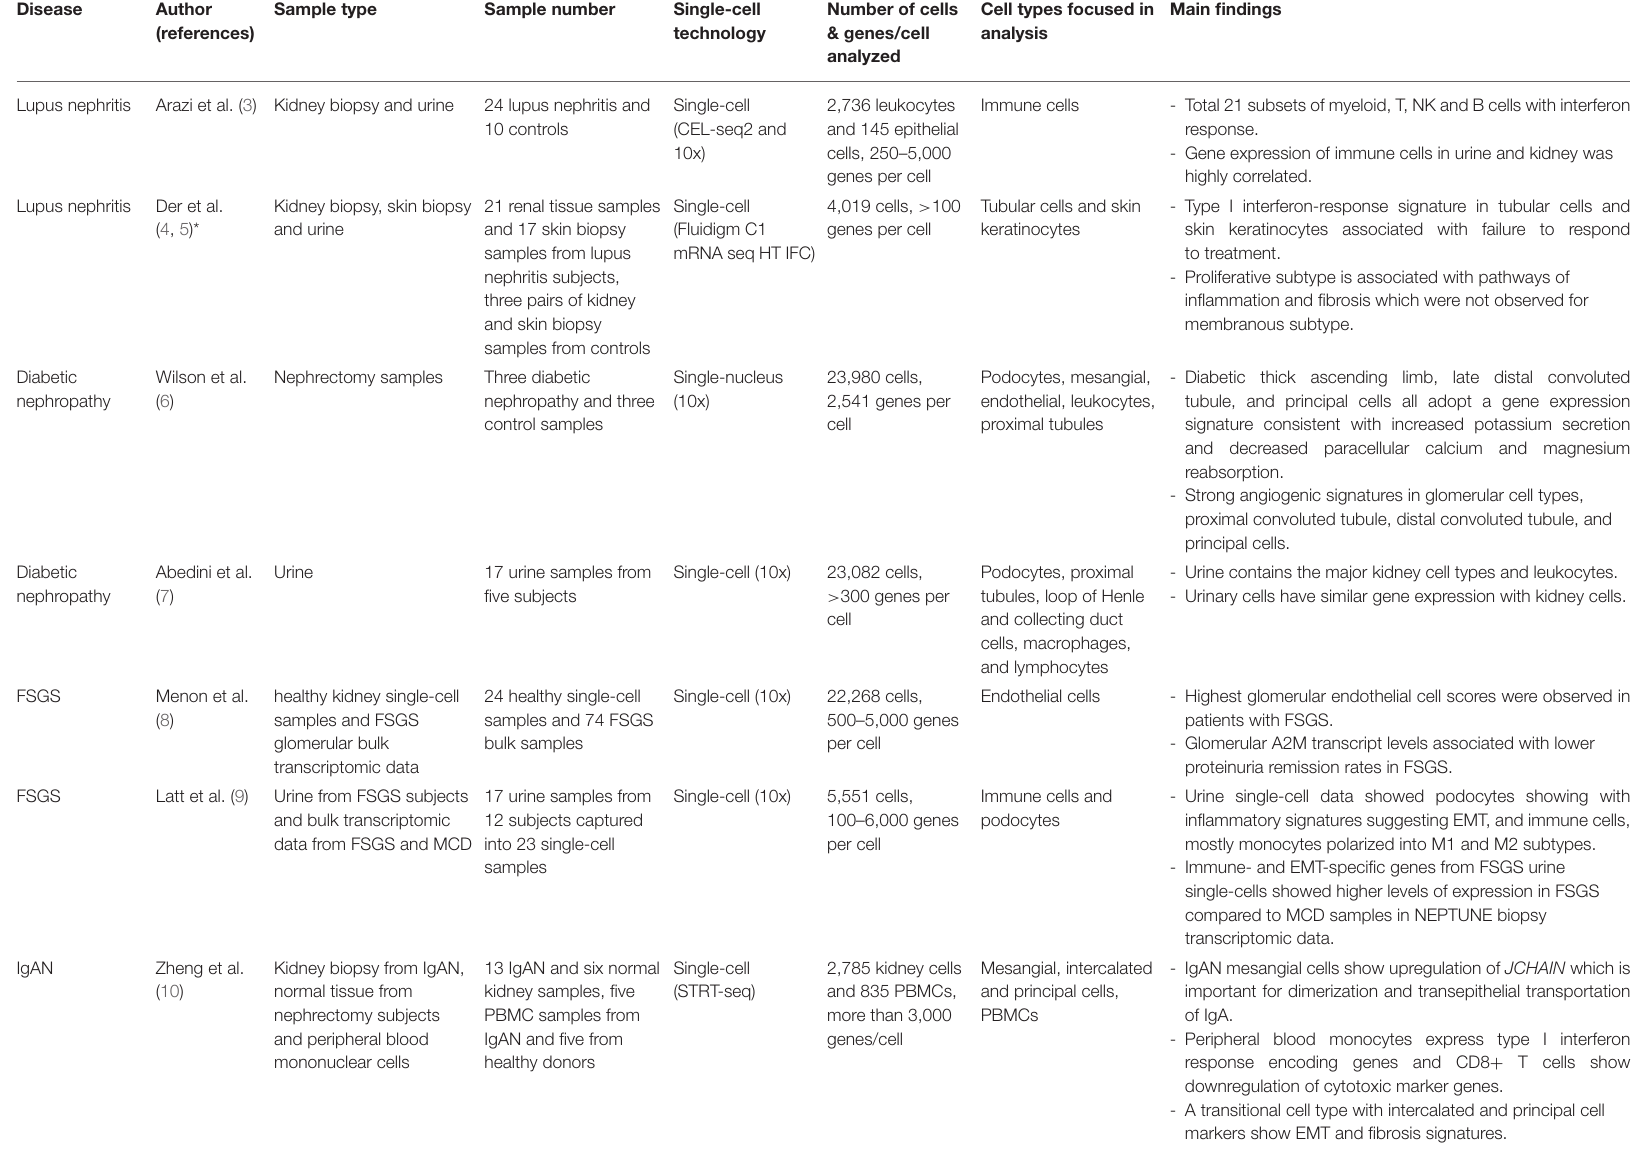
TABLE 1 | Summary of published glomerular disease studies applying single-cell/nucleus